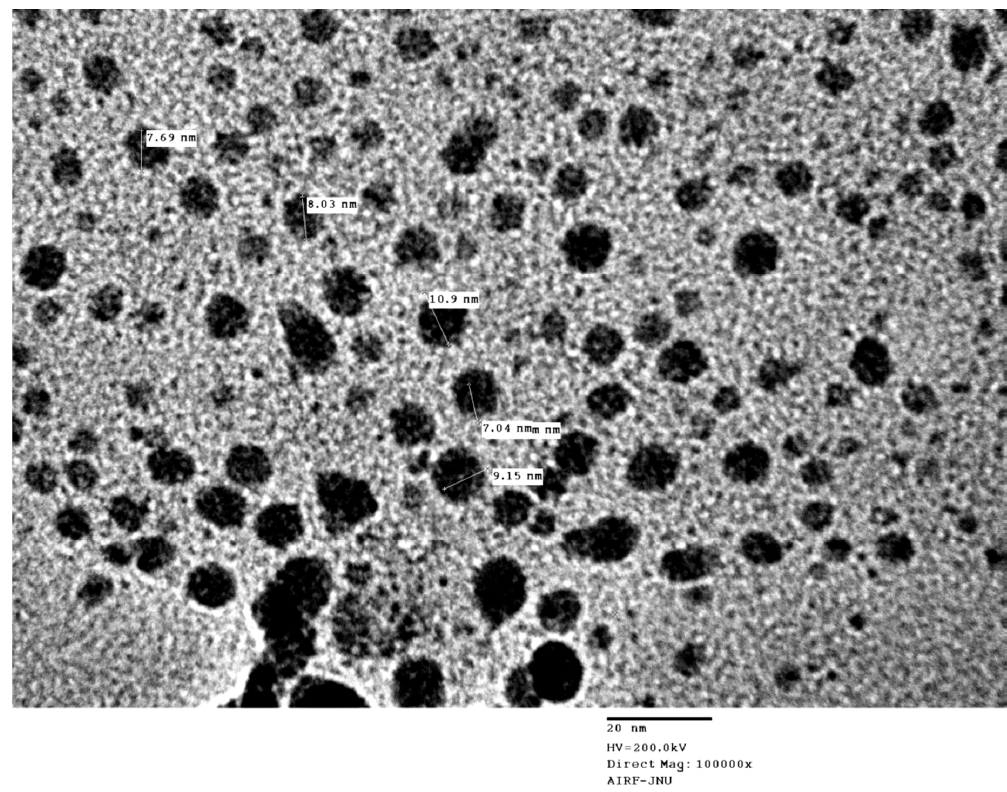
Figure 2. Transmission electron microscopy (TEM) image of biosynthesized AgNPs using Citrobacter spp. MS5 culture supernatant and AgNO 3 .